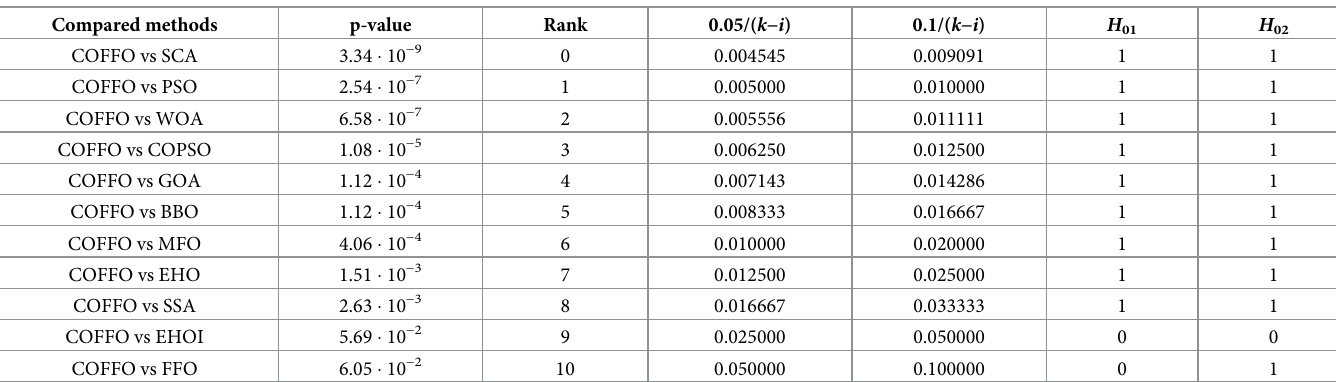
Table 6. Results of Holm’s step-down